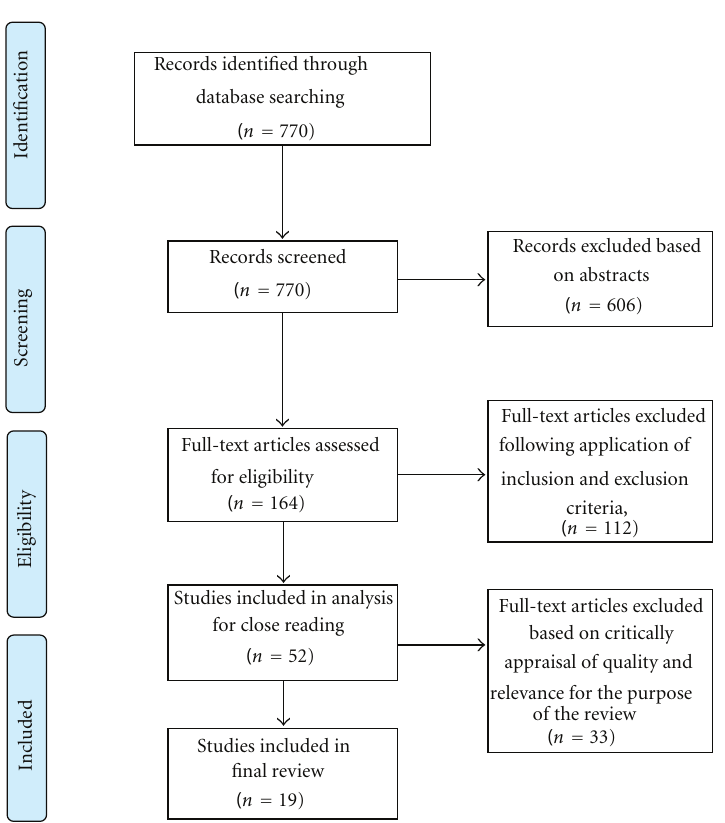
Figure 1: Flow diagram of the search process, adapted from Moher et al.